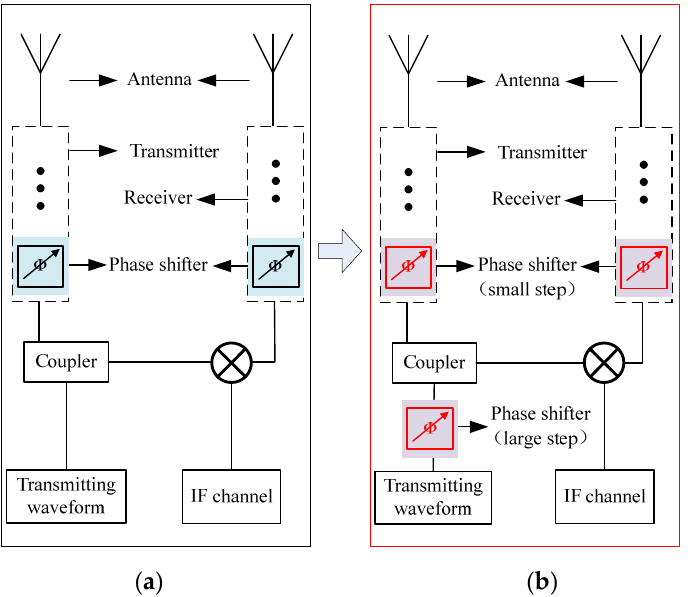
Figure 9. The W-Band active phased array antenna for the FMCW radar. ( a ) traditional scheme. ( b ) new scheme.